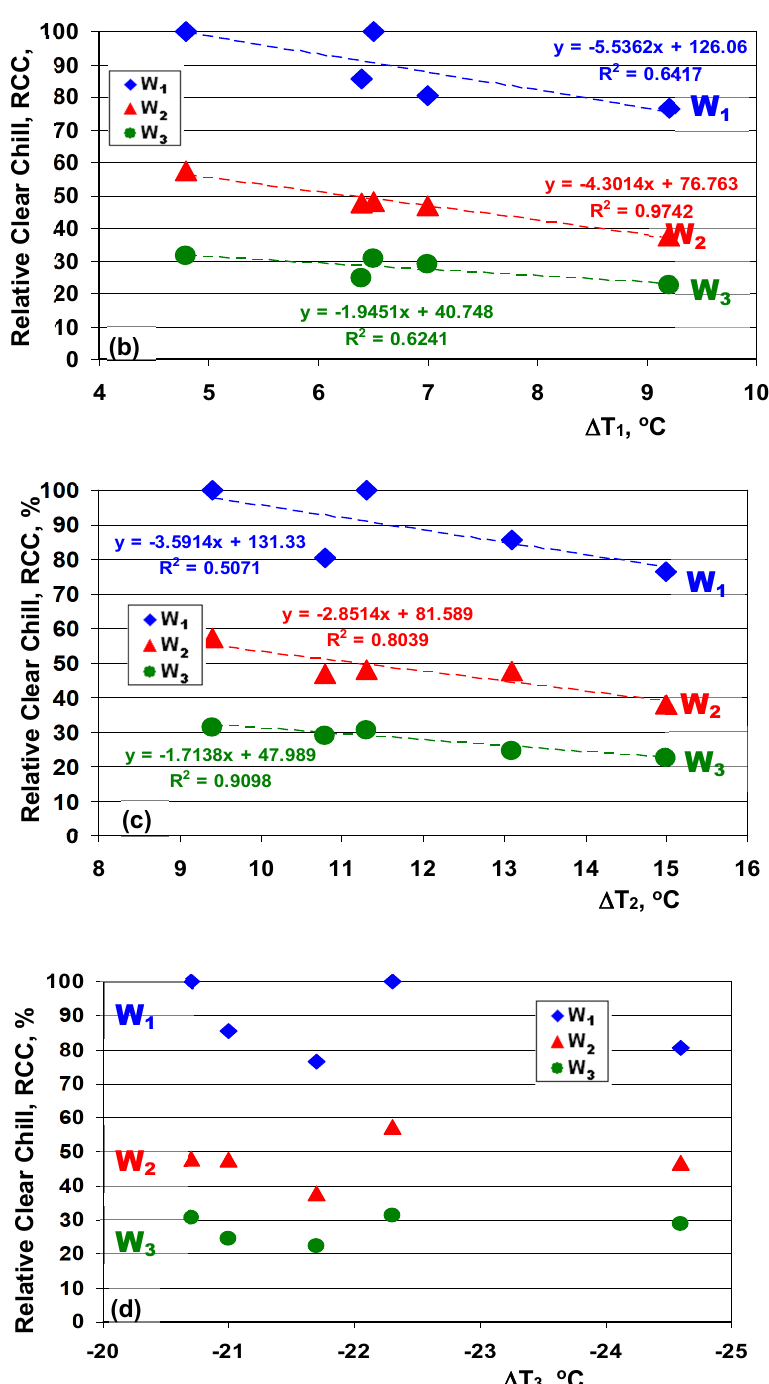
Figure 8. Relative clear chill (RCC) depending on wedge sample cooling modulus ( a ), ∆ T 1 ( b ), ∆ T 2 ( c ) and ∆ T 3 ( d ) of inoculated grey cast